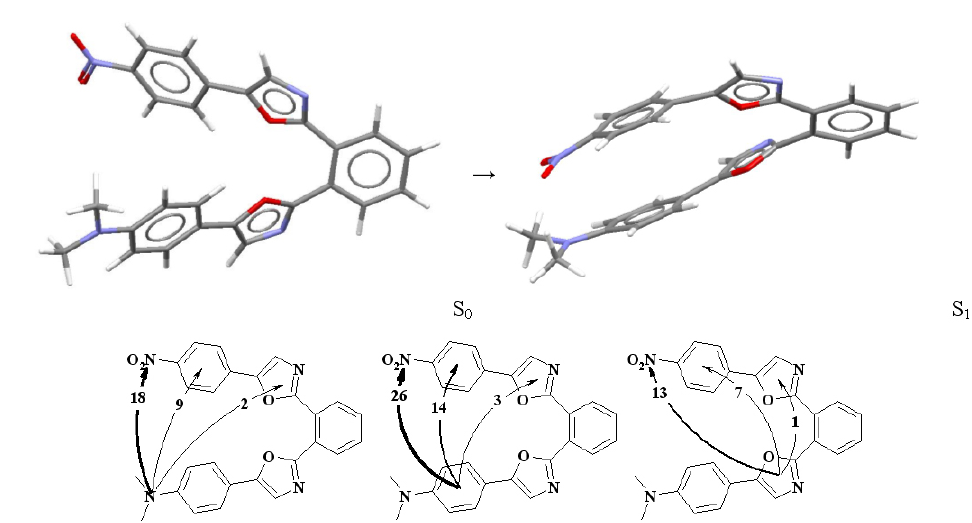
Figure 3. Ground ( b3lyp/cc-pvdz ) and excited state ( TD/b3lyp/cc-pvdz ) optimized molecular geometry of compound I and the electron density redistribution at electronic transition S